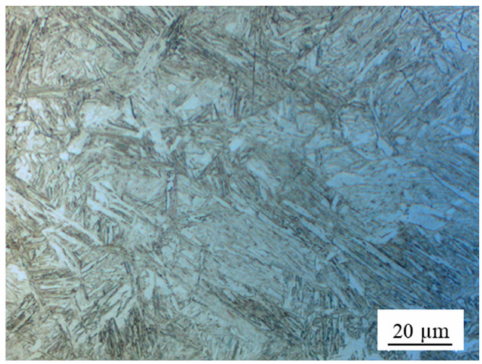
Figure 8. SEM micrograph of microstructures (mixture of refined ferrite ( α ) and martensite (M)) at the top surface for sample B top surface.